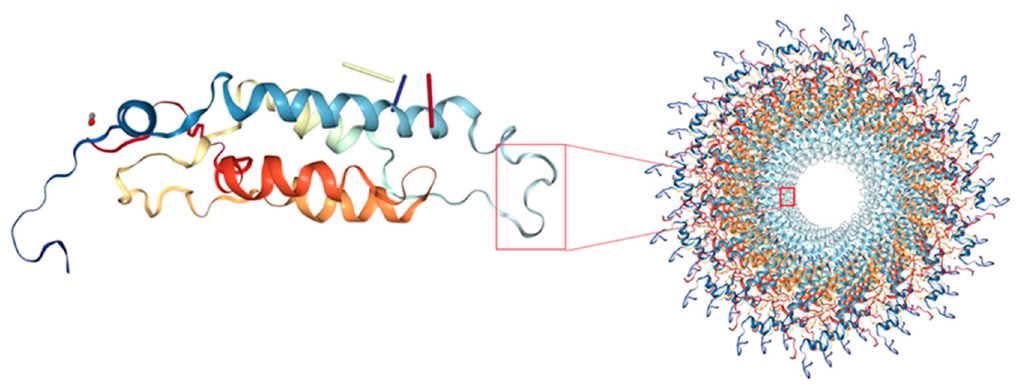
Figure 5. Three-dimensional model of the CGMMV coat protein. On the left is a CP subunit and on the right is the top view of the virion. The mutations are located within the red framed region.